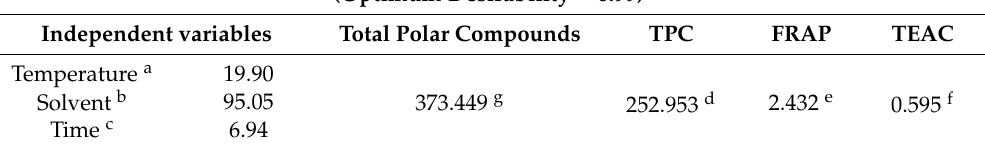
Table S1: MAE factorial design 2 3 experimental values of tested independent variables, Table S2: PLE factorial design 2 3 experimental values of tested independent variables, Equation (S1): Regression model equations of H. sabdari ff a , Equation (S2): Regression model equations of L. citriodora